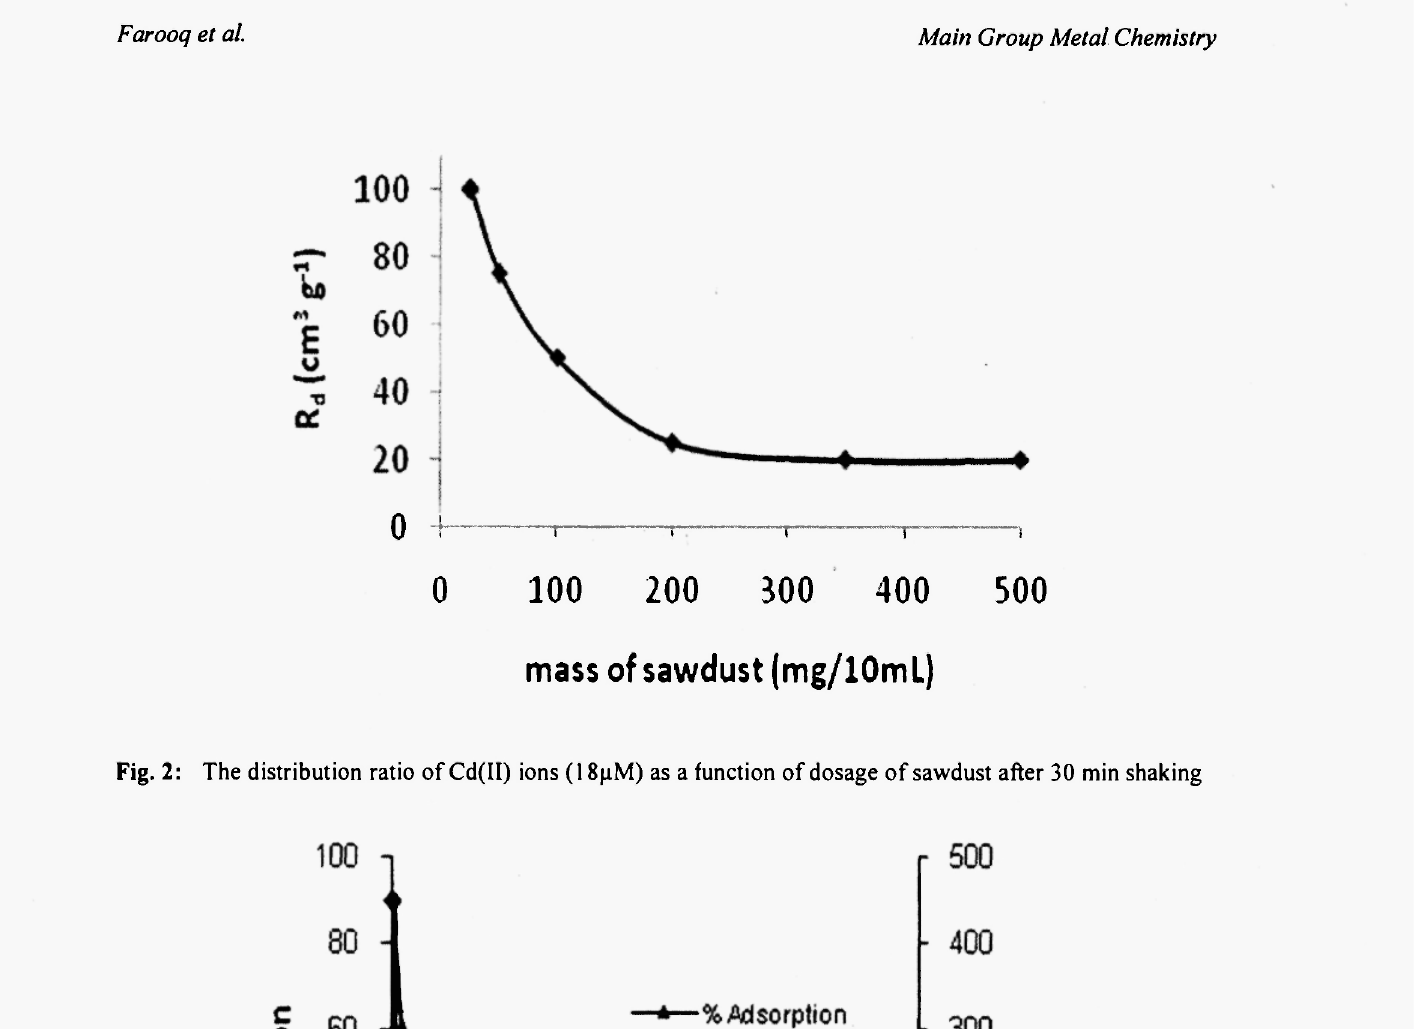
Fig. 2: The distribution ratio of Cd(II) ions (18μΜ) as a function of dosage of sawdust after 30 min shaking